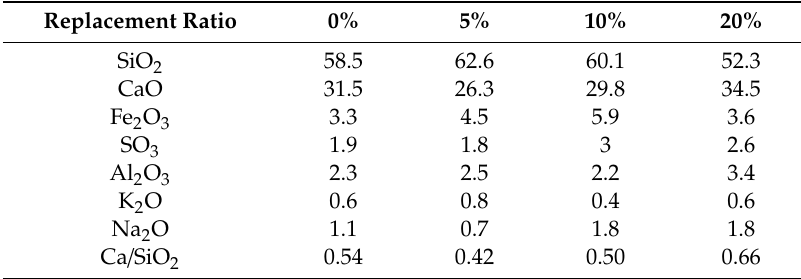
Table 6. XRF analysis of mortar with carbon